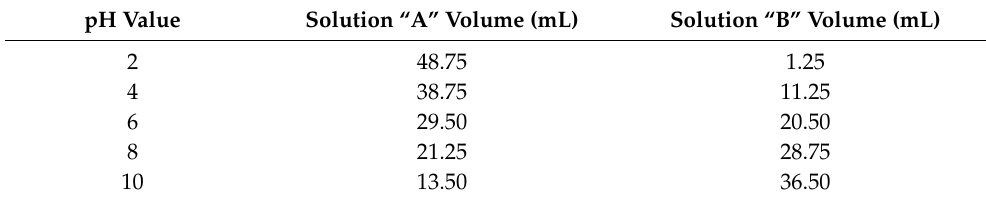
Table 1. Preparation of the pH buffer